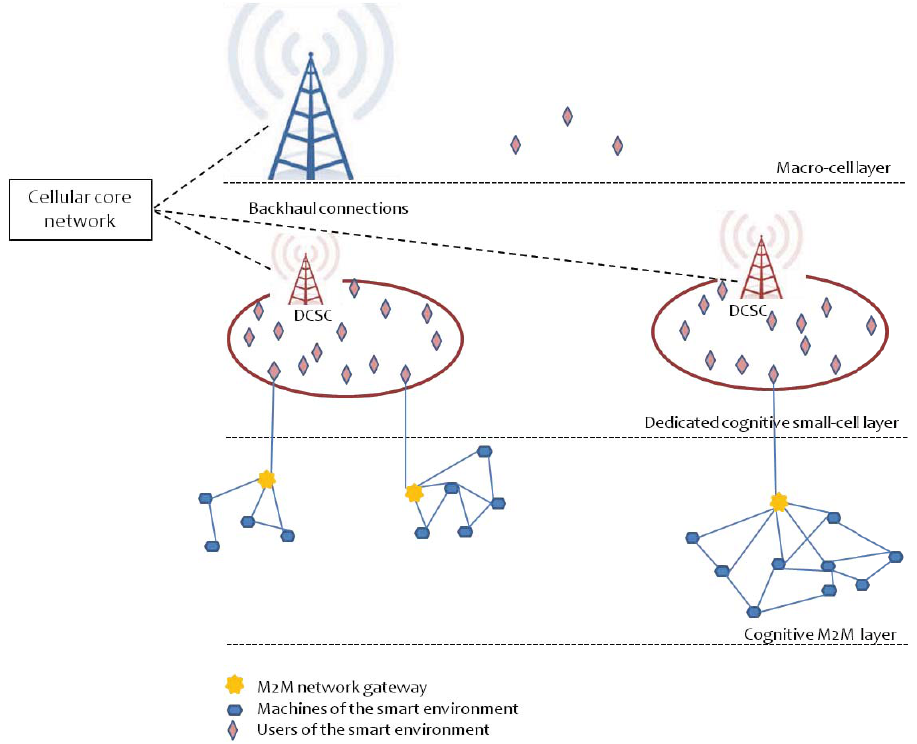
Figure 1. Cognitive communication architecture for smart city. M2M: Machine-to-Machine; DCSC: dedicated cognitive small